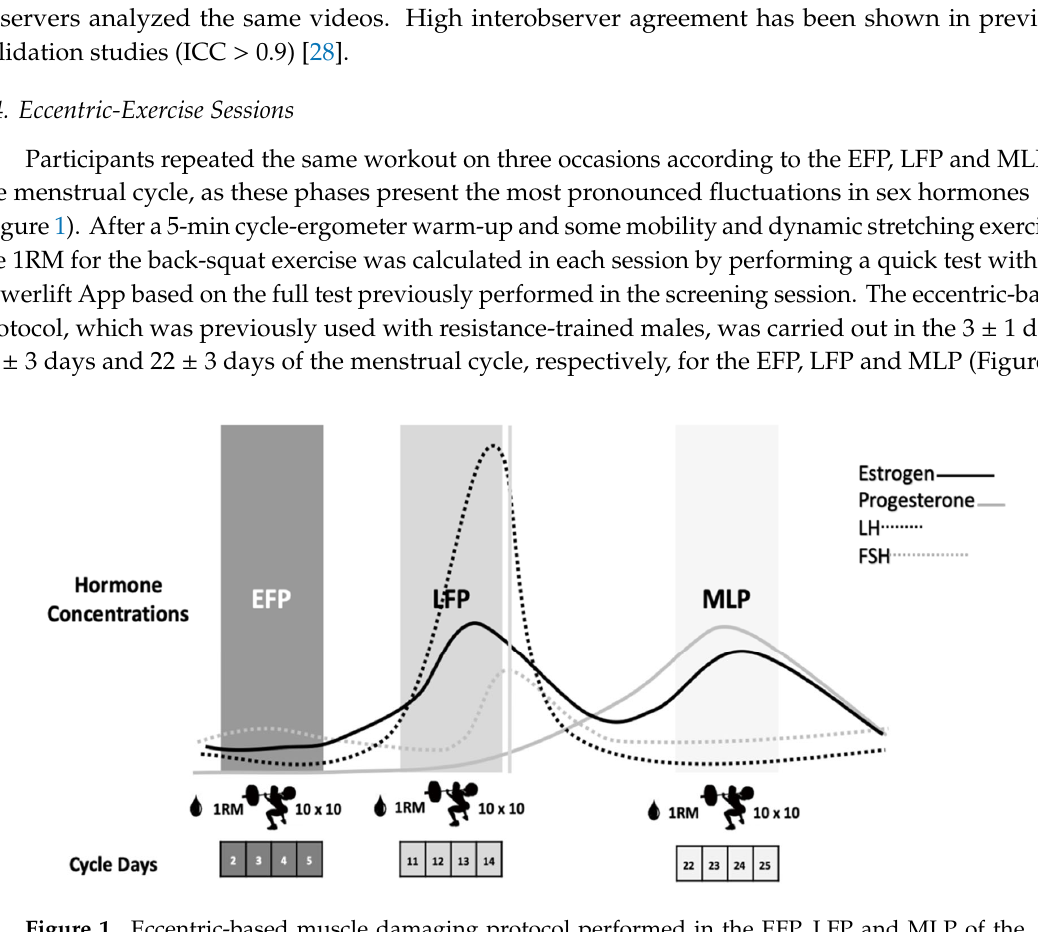
Figure 1. Eccentric ‐ based muscle damaging protocol performed in the EFP, LFP and MLP of the menstrual cycle. EFP: early follicular phase, LFP: late follicular phase, MLP: mid ‐ luteal phase. LH: luteinizing hormone, FSH: follicle stimulating hormone.